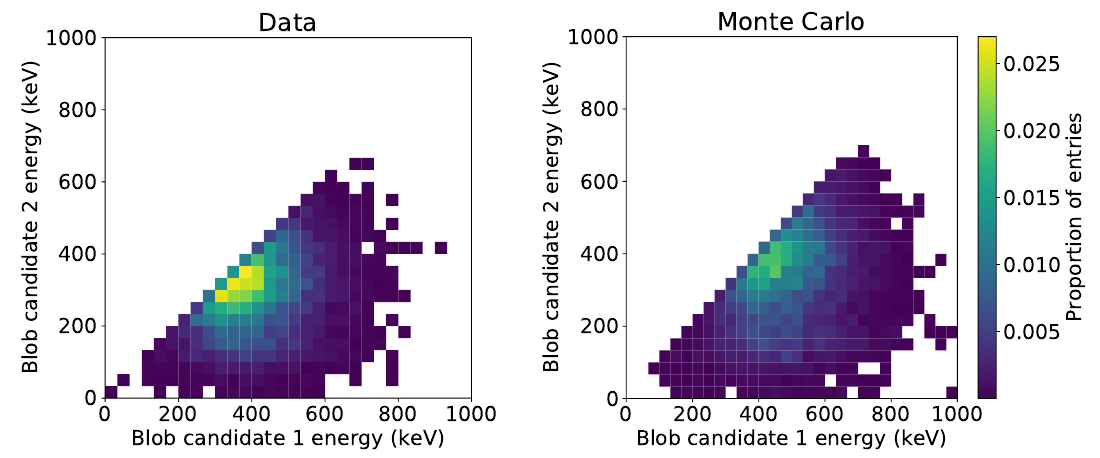
Figure 4 . Distribution of the energies of blob candidate 1 and blob candidate 2 for data (left) and Monte Carlo (right), in the 1570{1615 keV region, under the 208 Tl double escape